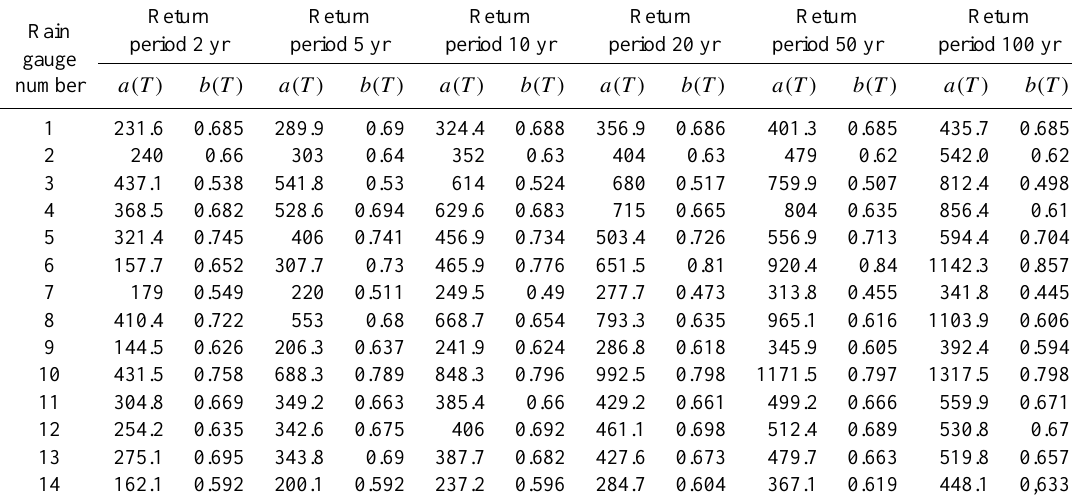
Table 2. Parameters a(T ) and b(T ) for the 14 stations studied for IDF (DGRE-ST2i, 2007).